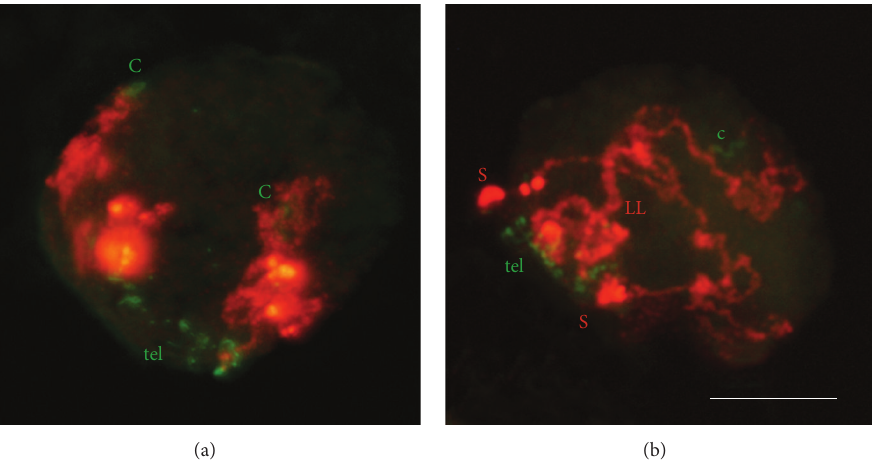
F 3: Arrangement of rye homologous chromosome pair 5R added to wheat at early meiosis. (a) Nucleus at leptotene showing highly compacted rye chromosomes located in separate territories. Chromosomes show the Rabl orientation with centromeres (c) and telomeres (tel) in opposite poles. Telomeres of wheat chromosomes, also labeled, are arranged in groups denoting the initiation of bouquet organization. (b) Nucleus at early zygotene showing partial synapsis of the long arm (LL) while the short arm ends (S) remain separate. e chromosome length is increased relative to leptotene, which causes that chromosomes span the entire nucleus. e centromere of one chromosome is out of focus. Bar represents 10